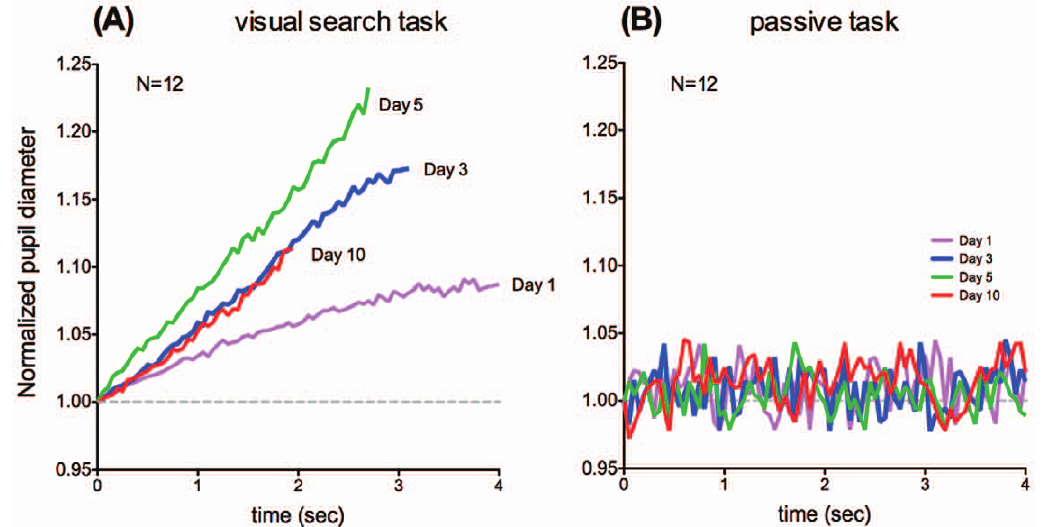
Figure 3. Normalized pupil diameter as a function of time. (A) Each function represents the averaged pupil diameter of 12 subjects during the conduction of the visual conjunction search task. The data in each trial was normalized relative to the pupil size during the cross fixation period immediately preceding the trial. Different functions denote the different training day: 1 st , 3 rd , 5 th , and 10 th day, respectively. (B) Each function represents the averaged pupil diameter of 12 subjects conducting the passive viewing task. In passive condition subjects observed the visual search display, but no task was imposed. The data in each trial was normalized relative to the pupil size during the cross fixation period immediately preceding the trial. Different functions denote the different experimental day: 1 st , 3 rd , 5 th , and 10 th day, respectively. doi:10.1371/journal.pone.0021973.g003 condition. Blank triangles in Figure 4 show the averaged pupil diameter as a function of day in the passive condition, calculated from Fig. 3(B). The pupil diameter is normalized by the diameter during the cross fixation period immediately preceding the trial. A